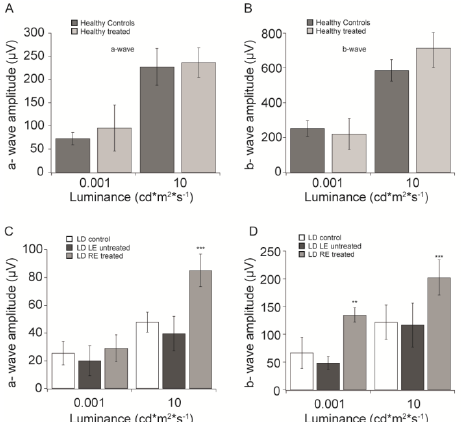
Figure 1. CBS treatment preserves retinal function. ( A ) a-wave amplitudes (mean ± SD) recorded from healthy controls (HC, black) and CBS treated healthy animal (HC treated, gray) in response to 0.001 and 10 cd*m2*s-1 flashes. ( B ) b-wave amplitudes (mean ± SD) recorded from healthy controls (HC, black), and CBS treated healthy animal (HC RE treated, gray) in response to 0.001 and 10 cd*m2*s-1 flashes. ( C ) a-wave amplitudes (mean ± SD) recorded from light damaged animals with no CBS treatment (LD control, white), the untreated eye of a light damaged animal (LD LE untreated, black) and CBS treated eye of a light damaged animal (LD RE treated, gray) in response to 0.001 and 10 cd*m2*s-1 flashes. ( D ) b-wave amplitudes (mean ± SD) recorded from light damaged animals with no CBS treatment (LD control, white), the untreated eye of a light damaged animal (LD LE untreated, black) and CBS treated eye of a light damaged animal (LD RE treated, gray) in response to 0.001 and 10 cd*m2*s-1 flashes. ** p < 0.01; *** p < 0.001 .